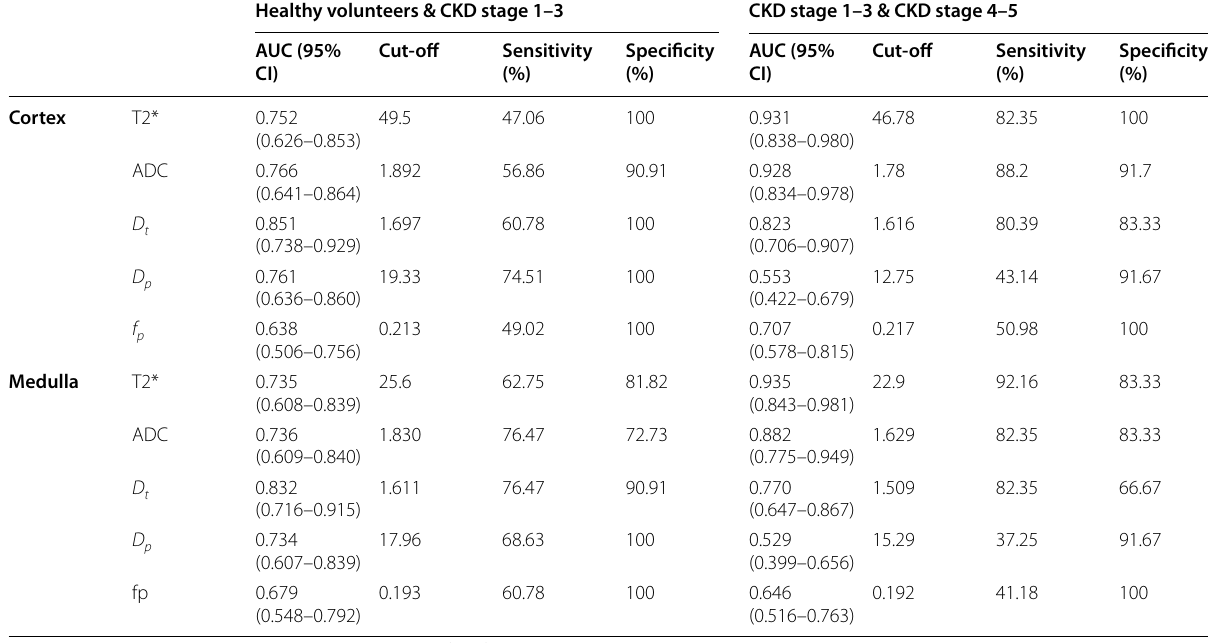
The unit of T2* is ms; ADC, D t and D p value are given as 10 –3 mm 2 /s. The f value is dimensionless × ROC receiver operating characteristic, AUC area under the receiver operating characteristic curve, CI confidence interval, ADC apparent diffusion coefficient, D t pure diffusion coefficient, D p perfusion-related diffusion coefficient, f p pseudodiffusion